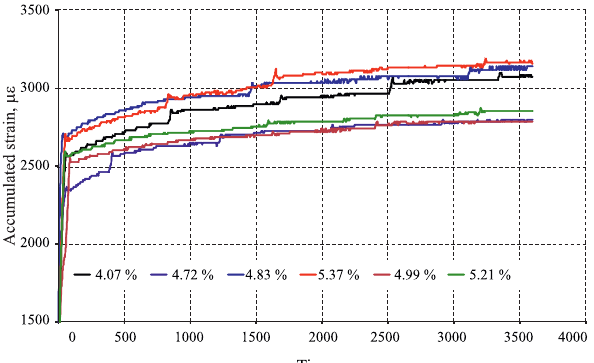
Fig. 1. Accumulated strain versus time graphs for 6.0‰ polypropylene modified specimens